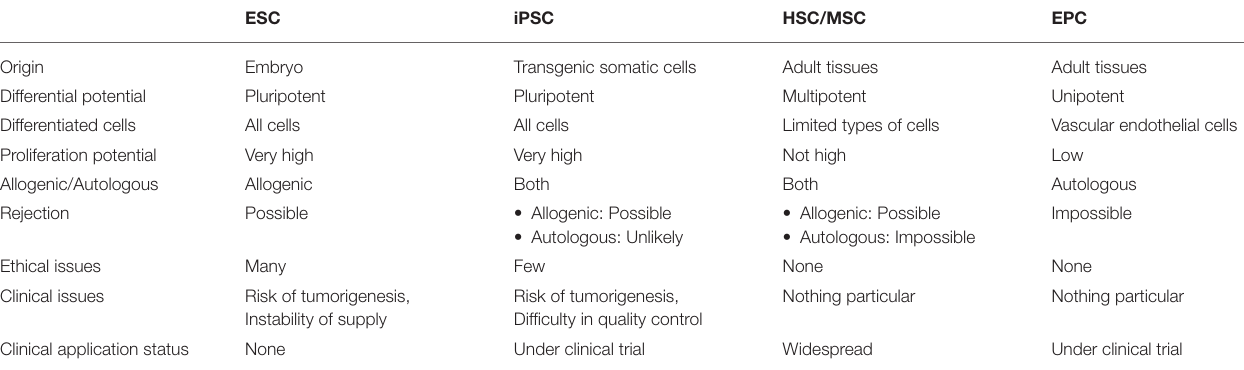
TABLE 1 | Comparison of the properties of cells used in regenerative